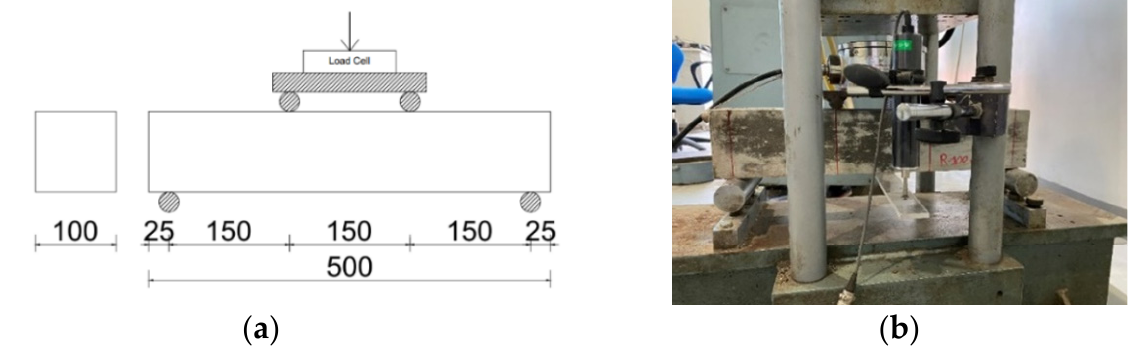
Figure 3. Four-point bending test setup: ( a ) schematic representation (dimensions are in mm); ( b ) test in progress.